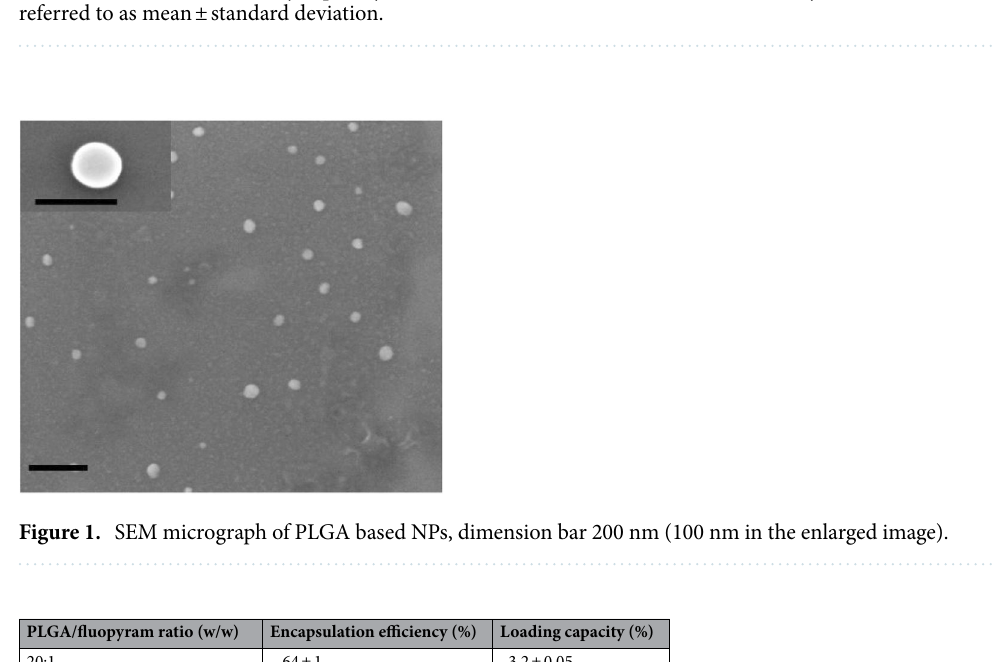
PLGA/fluopyram ratio (w/w)